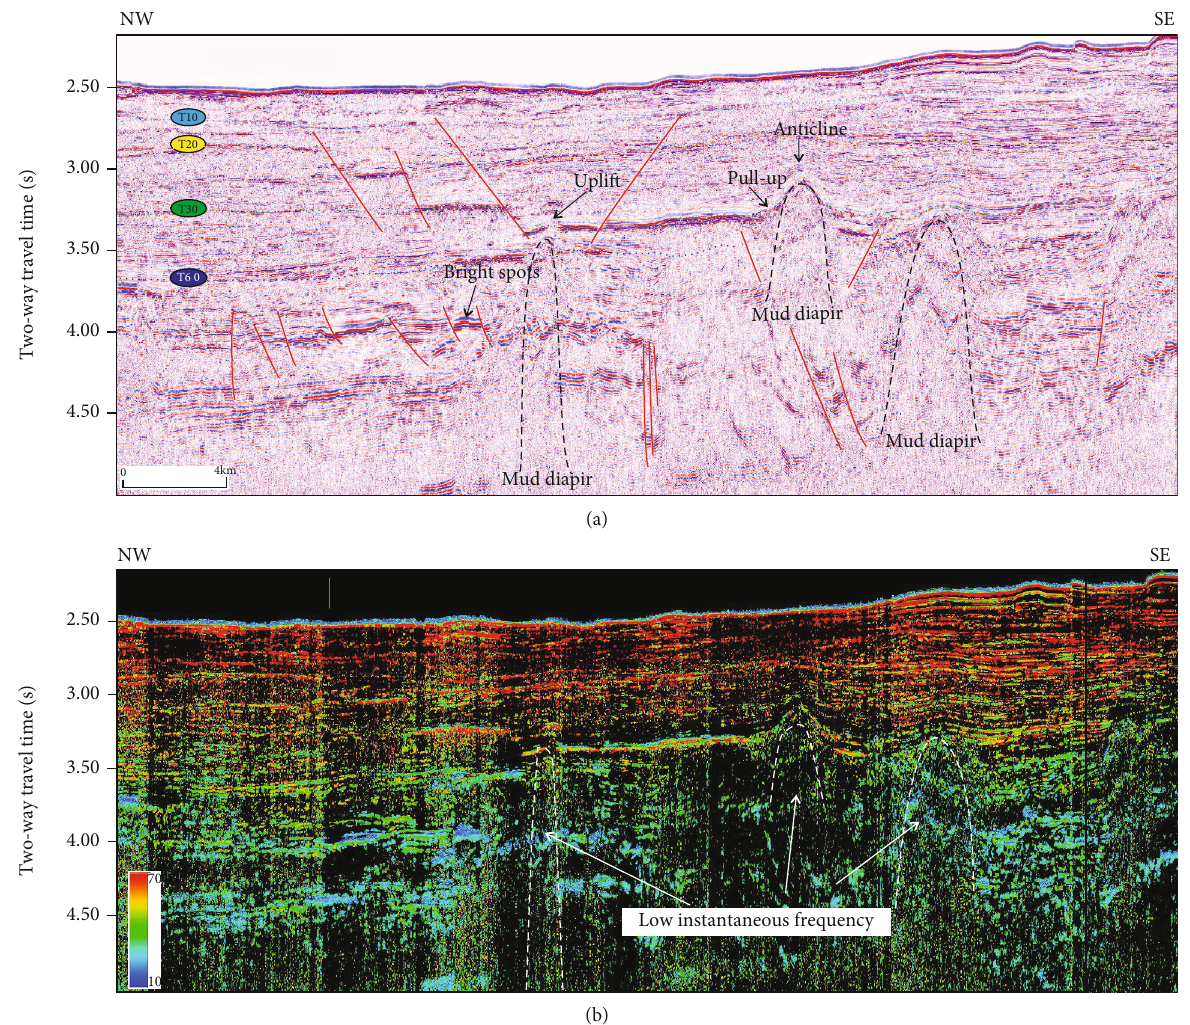
Figure 4: (a) Seismic pro fi le over the Qiongdongnan Basin. Mud diapirs puncture into the Neogene strata in a vertical columnar or chimney- like form. Diapir intrusions caused arch-up deformation of the overlying strata and “ uplift ” of the wall layers. The interior of the diapirs is characterized by blank, clutter, bright spots and other abnormal seismic re fl ection characteristics. (b) Instantaneous frequency distribution map. The blank or cluttered re fl ection area presents a low instantaneous frequency from the deep to shallow part on the instantaneous frequency distribution pro fi le, which is signi fi cantly di ff erent from the higher instantaneous frequency value of the surrounding